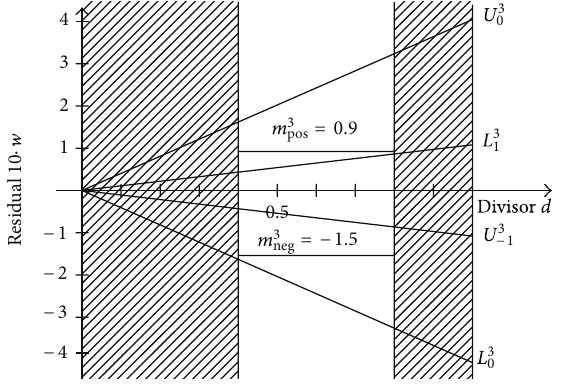
Figure 6: P-D diagram for the type4 QDS function.